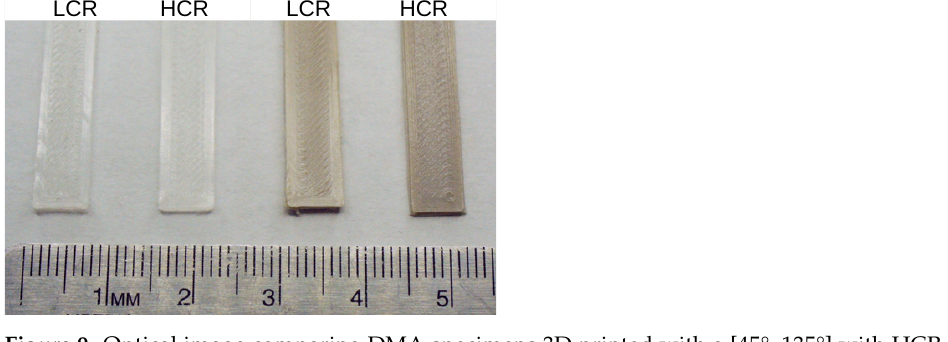
Figure 9. Optical image comparing DMA specimens 3D printed with a [45°, 135°] with HCR and LCR printing